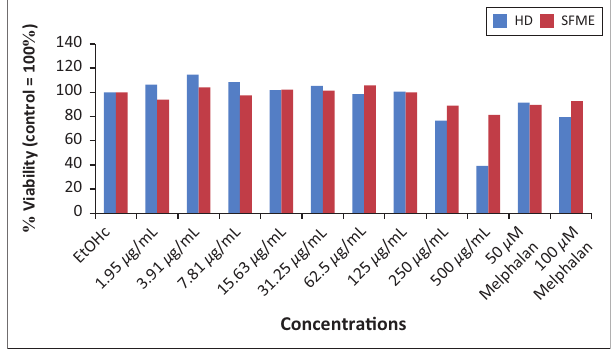
FIGURE 2: Cytotoxicity effects of volatile oil obtained by solvent-free microwave extraction and hydrodistillation against the human dermal fibroblast cell